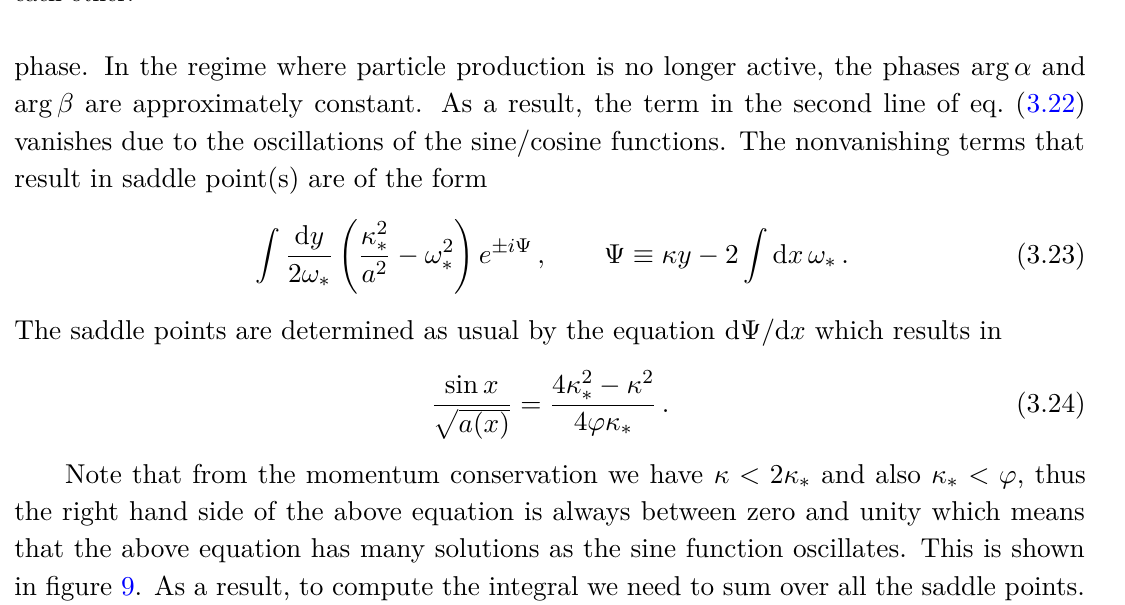
Figure 9 . Different solutions of the saddle equation (3.24) are shown on the top. In the bottom, the behaviour of the integrand around these saddle points is depicted. The two solution must be accounted as a distinct saddle point as long as they are well separated. Distinct saddles that appear around each maximum of the sine function contribute with different signs thus approximately cancel each